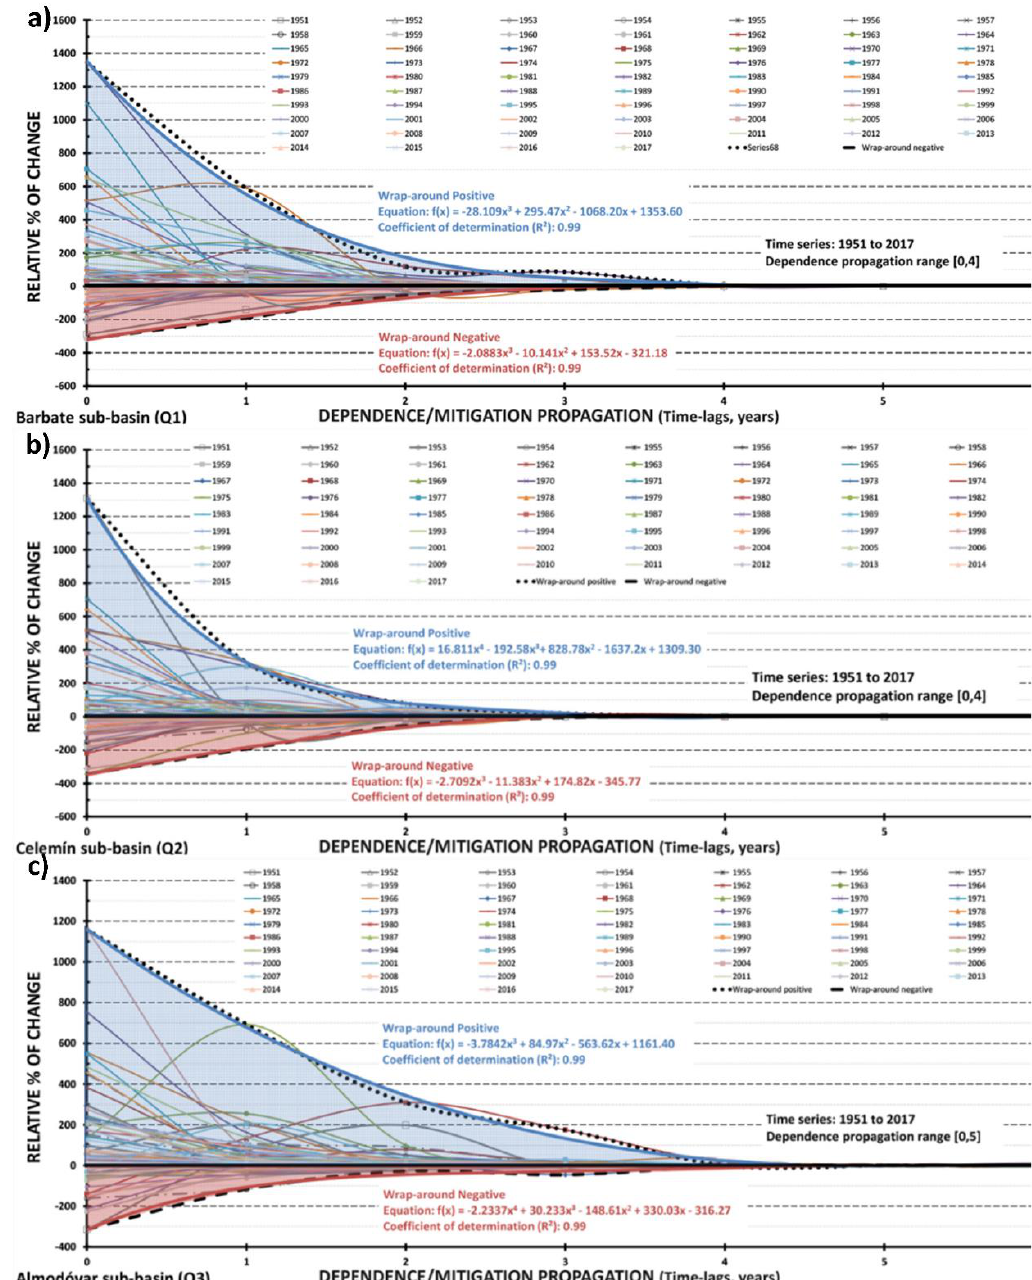
Figure 10. Dependence mitigation graphs (DMGs) for a long series (1951–2017) using the T-RRM: ( a ) Barbate Q1 sub-basin; ( b ) Celemín Q2 sub-basin; ( c ) Almodóvar Q3 sub-basin.